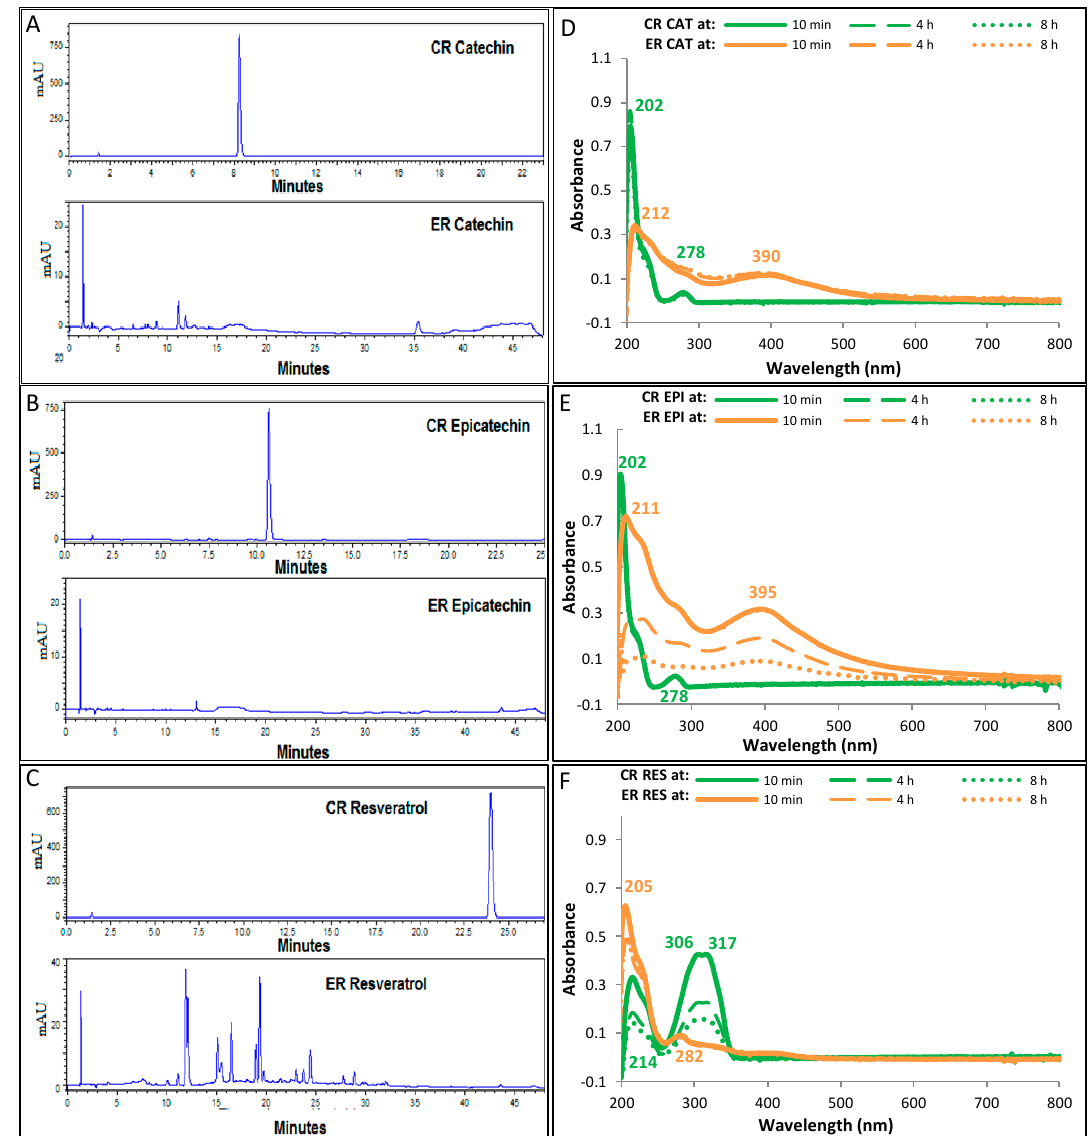
Figure 1. Reversed phase high performance liquid chromatography (RP-HPLC) chromatograms of the control reaction (CR) and enzymatic reaction (ER) with ( A ) catechin (CAT), ( B ) epicatechin (EPI), and ( C ) resveratrol (RES), at 10 min of reaction. The graphs ( D – F ) show the ultraviolet-visible (UV-Vis) absorption spectra of the CR and ER with each polyphenolic compound at di ff erent reaction times. Concentrations of phenolic compounds (PCs), peroxidase, and hydrogen peroxide (H 2 O 2 ) in the reaction medium of the ER were 1.5 mM, 2.5 U / mL, and 0.05%, respectively. In the CR, peroxidase was substituted by phosphate bu ff er solution. mAU: milli arbitrary area units.